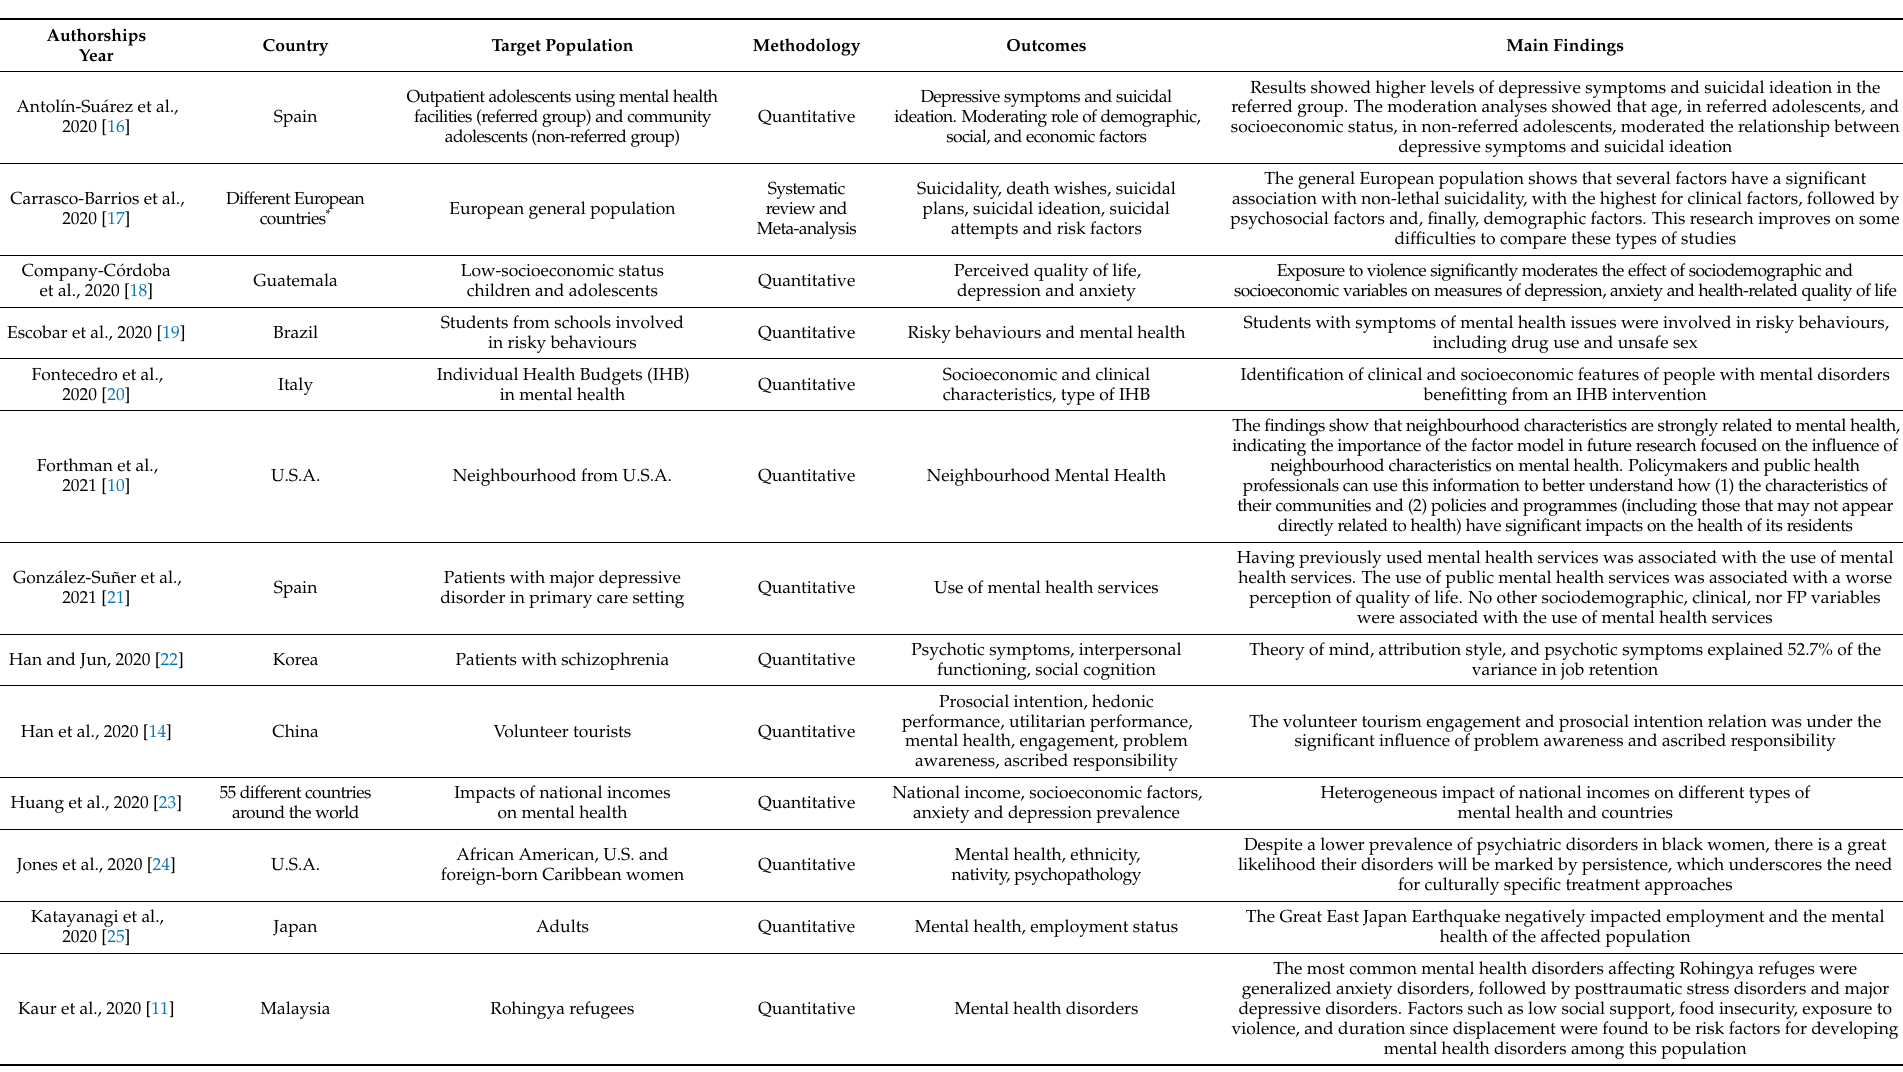
Table 1. Description of the articles included in the Special Issue in alphabetical